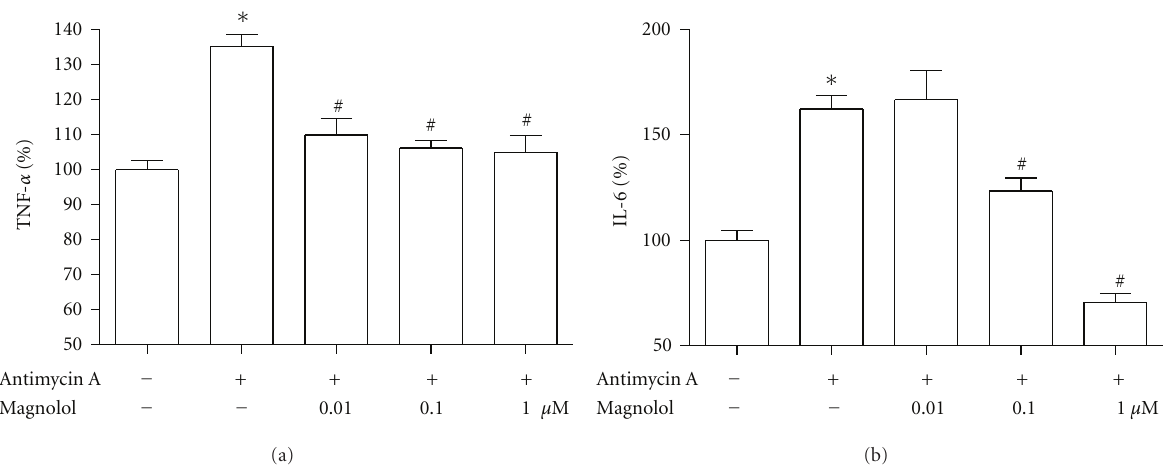
Figure 7: E ff ect of magnolol on antimycin A-induced cytokines production of MC3T3-E1 cells. Osteoblasts were preincubated with magnolol before treatment with 70 μ M antimycin A for 48 h. Data were expressed as a percentage of control. The control values for TNF- α (a) and IL-6 (b) were 0.228 ± 0.006 ng/mg and 0.655 ± 0.033 ng/mg, respectively. ∗ P < 0 . 05, control versus antimycin A; # P < 0 . 05, antimycin A versus